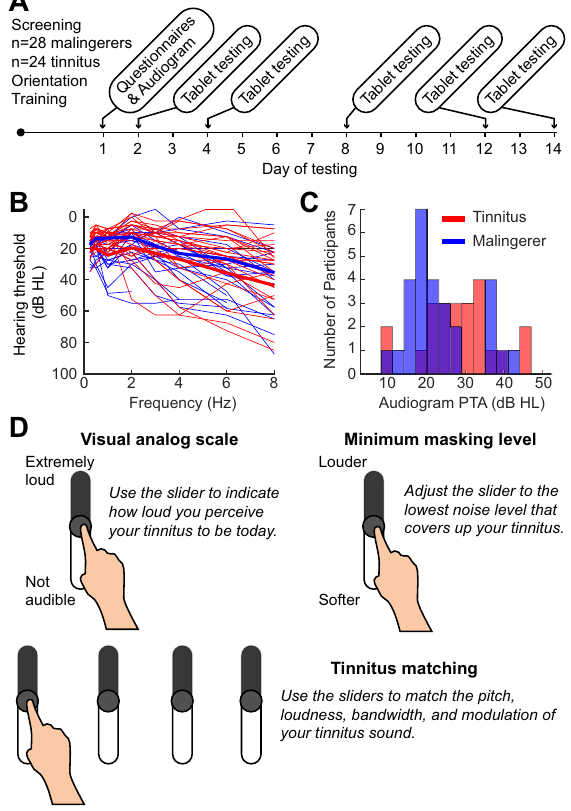
Fig. 7 Summary of tinnitus characterization procedure. A Schematic of experimental design. B , C Audiograms ( A ) and pure tone average ( B ) for tinnitus patients (red) and a malingering cohort (blue), who were subsequently instructed to feign having tinnitus. D Graphical User Interface to characterize tinnitus loudness, minimum masking level, and to match tinnitus with visual